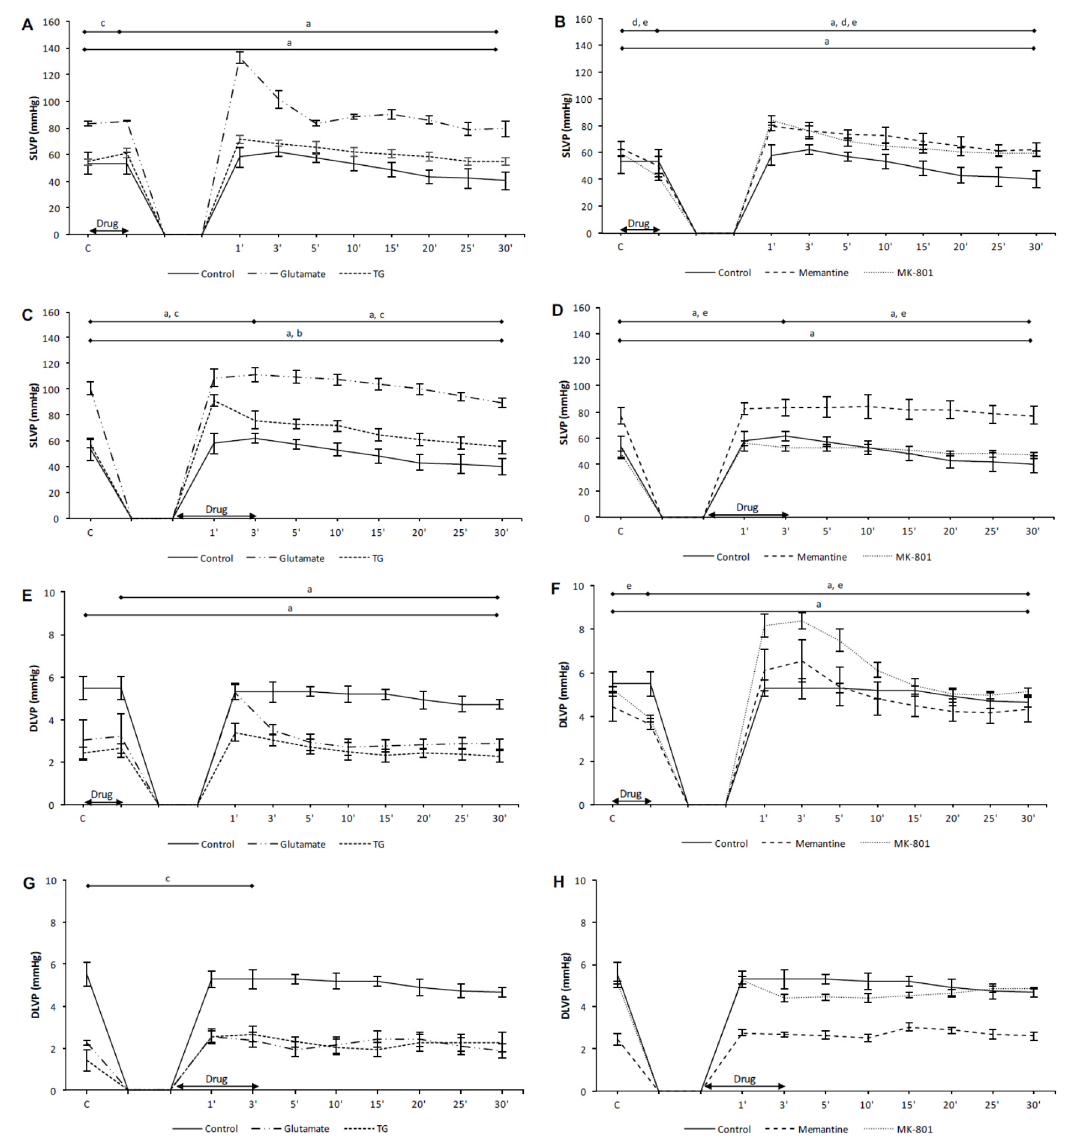
Figure 2. The effects of cardiac NMDAR modulation in preC and postC on systolic and diastolic pressure. ( A , E ) preconditioned with glutamate and TG; ( B , F ) preconditioned with memantine and MK-801; ( C , G ) postconditioned with glutamate and TG; ( D , H ) postconditioned with memantine and MK-801. SLVP—systolic left ventricular pressure; DLVP—diastolic left ventricular pressure; TG—(RS)-(Tetrazol-5-yl)glycine; preC—preconditioning; postC—postconditioning. Statistical significance between points of interest was presented as: a—in control group; b—in glutamate group; c—in TG group; d—in memantine group; e—in MK-801 group. Statistical significance was considered significant if the p value was less than 0.05 ( p < 0.05).